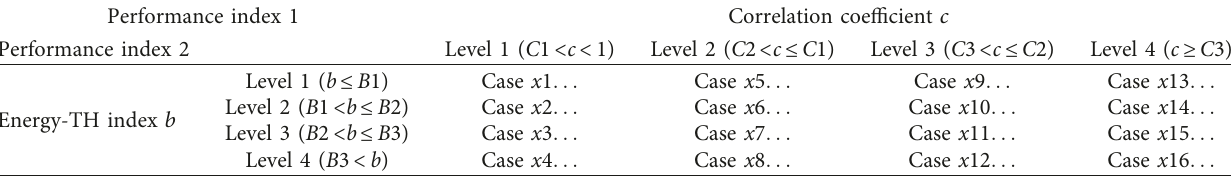
Table 2: Shake table performance assessment strategy based on the double parameter indices.